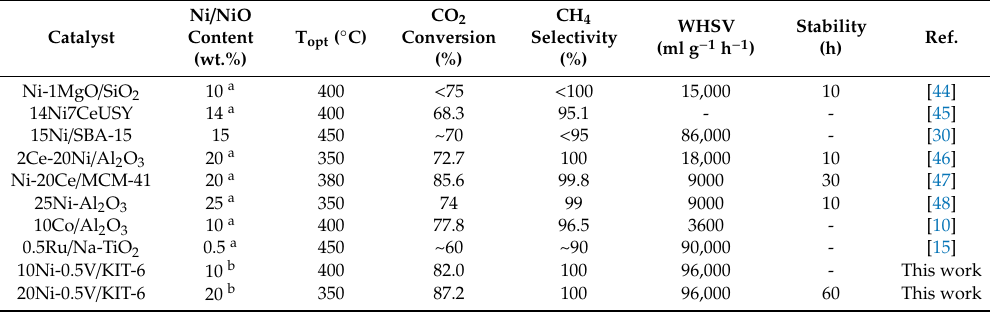
Table 2. Comparison of CO 2 conversion and CH 4 selectivity for 20Ni-0.5V/KIT-6 in our study and some catalysts reported in the literature at 1atm with the optimum temperature.